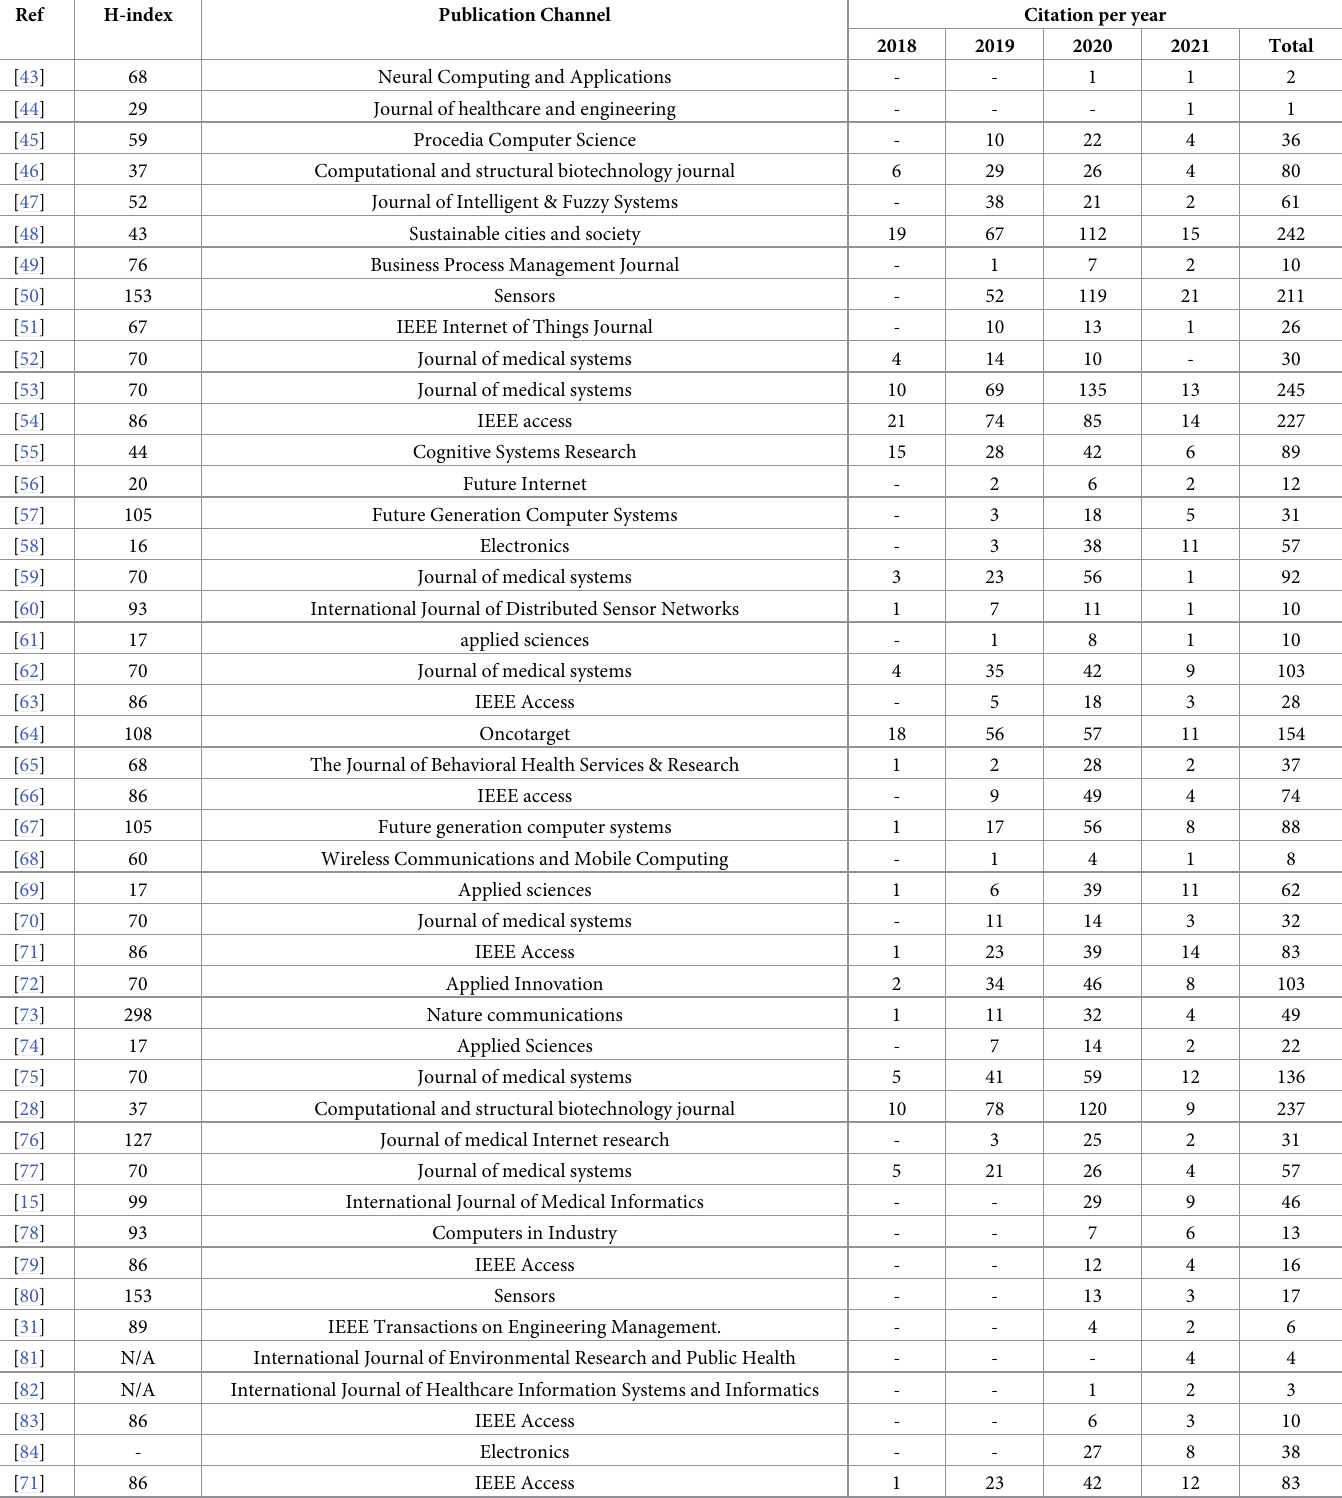
Table 1. List of the selected papers with details of QE, publication channel, year, H-index, and citation per year.